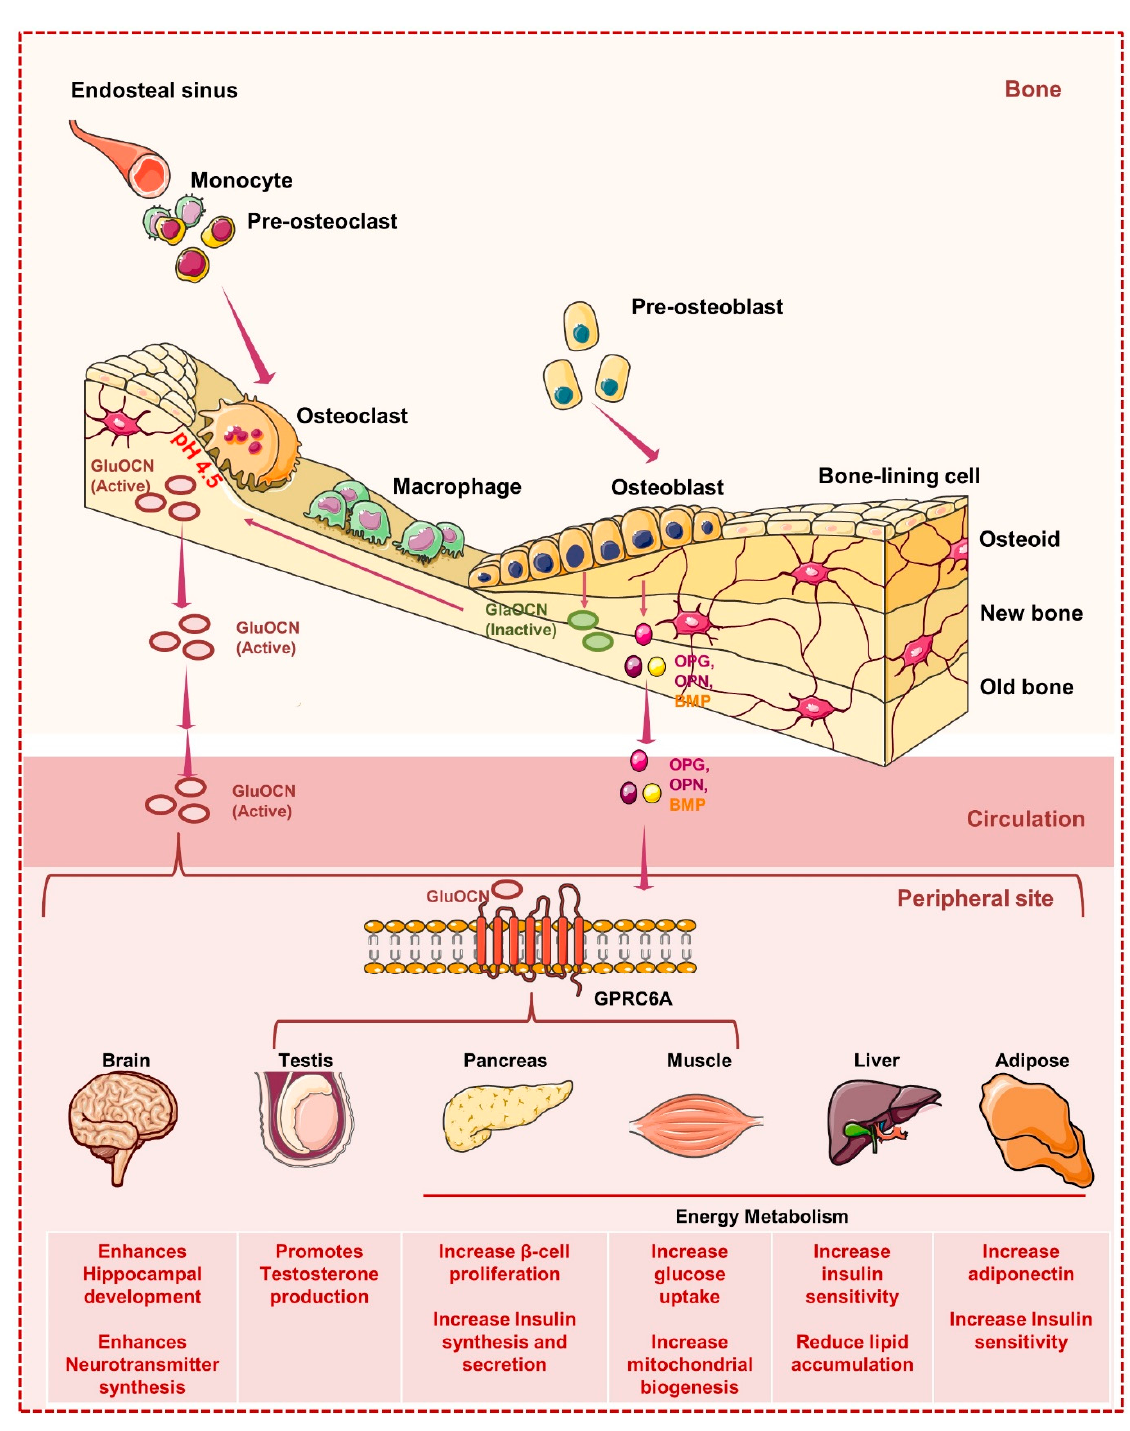
Figure 5. Bone cells and global energy metabolism: Osteoblasts release OCN, which is C-carboxylated (GlaOCN), into the bone extracellular matrix (ECM). Osteoclasts form bone resorption lacunae having acidic pH (~4.5) to aid the decarboxylation of GlaOCN to GluOCN. GluOCN enters into the circulation and acts as an endocrine hormone. GluOCN controls global energy metabolism by regulating the uptake of glucose in the muscles, production of insulin in the pancreas, enhancement in the adiponectin expression in the adipose tissues, promoting the proliferation of β -cell in the pancreas. In addition to controlling energy metabolism, OCN regulates the synthesis of testosterone by the Leydig cells and thus controls male fertility. It also facilitates the development of the hippocampus region of the brain. Strikingly, in the tissues like the testis, muscles, and pancreas, OCN regulates